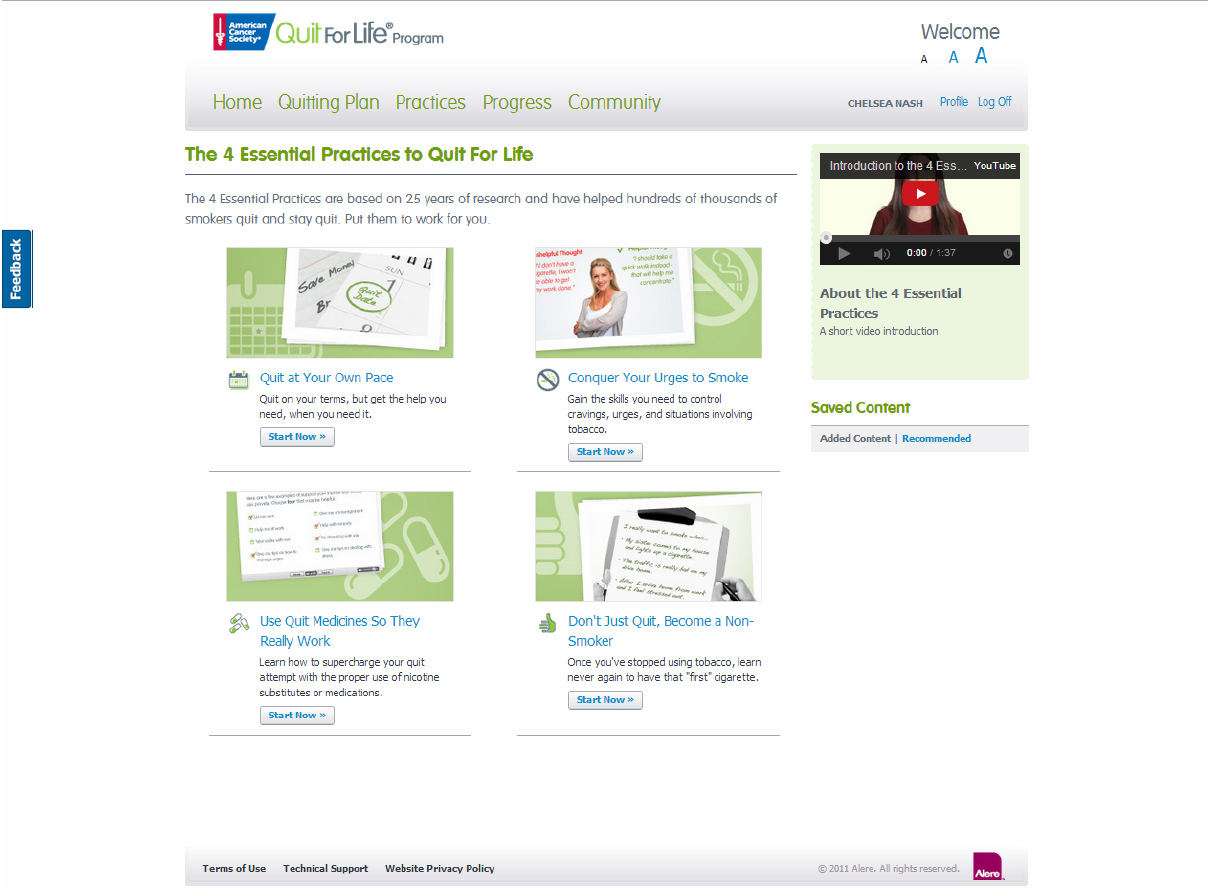
Figure 6. Screenshot of Practices